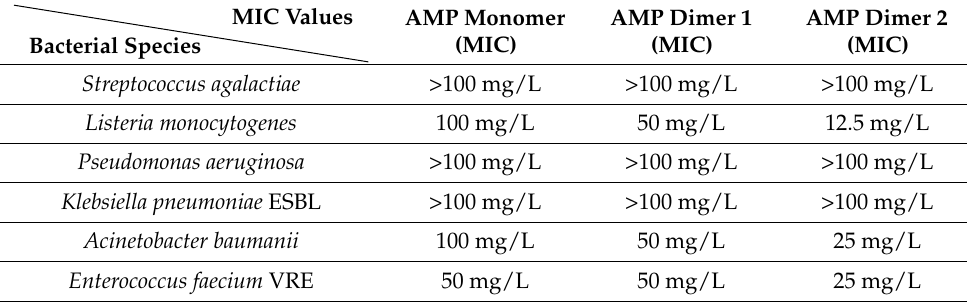
Table 2. MIC determinations of CMP5 cys-cys monomer and dimer 1 and dimer 2. MIC determina- tions were performed in the Mueller–Hinton broth in accordance with CLSI guidelines, following overnight incubation at 37 ◦ C. All tests were performed in